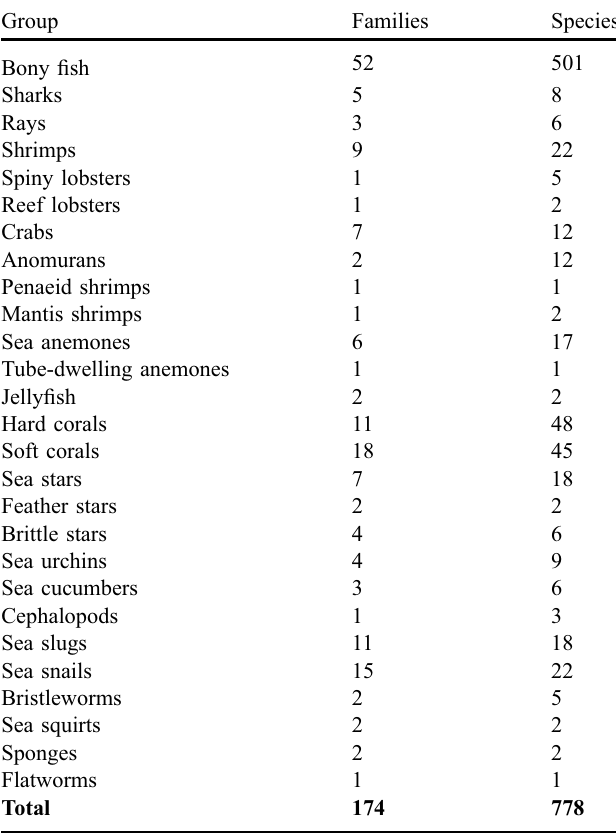
Table 3. Groups of marine animals found being traded in Indonesia in 2018, and number of families and species in each group.